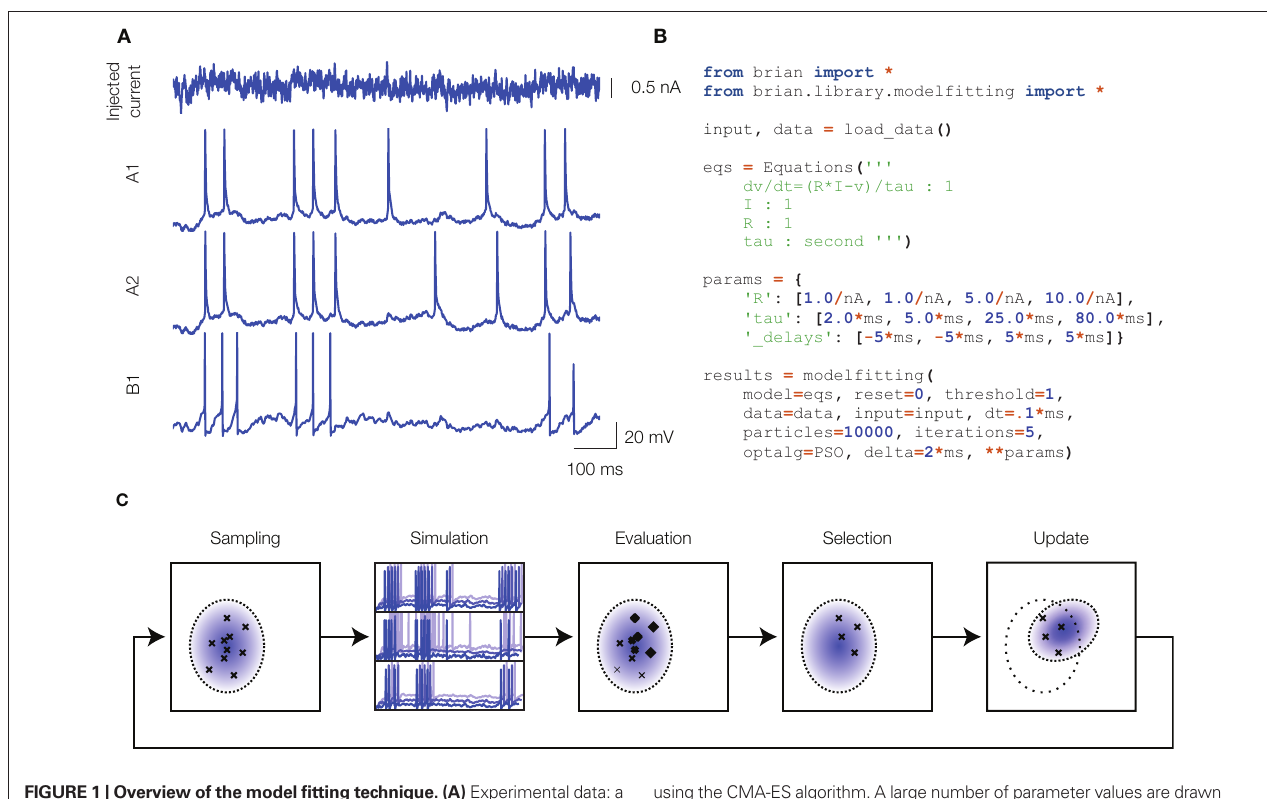
Figure 1 | Overview of the model fitting technique. (A) Experimental data: a fluctuating current is injected into the neuron (top) and the responses are recorded (only spike trains are used). The first two traces correspond to two different trials in the same cortical neuron, the third trace is the response of another neuron. (B) Python script to fit an integrate-and-fire model to the experimental data: the model is defined in its mathematical form, and initial parameter values are specified. (C) Illustration of the optimization procedure